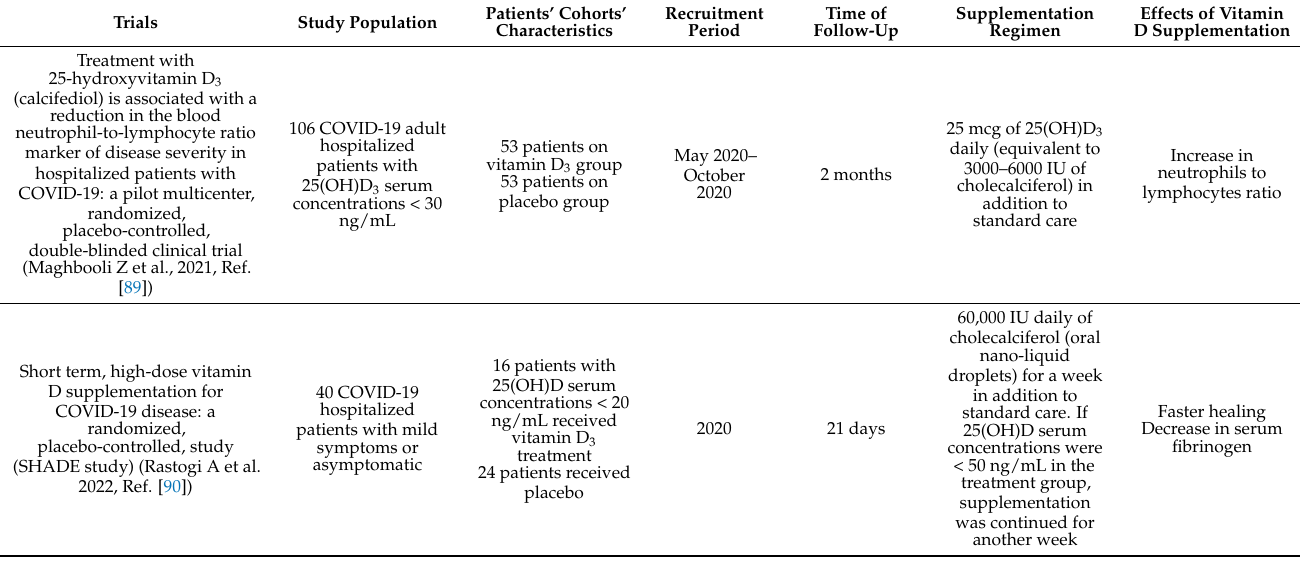
Table 1. Randomized double-blind, placebo controlled clinical trials regarding the biological and clinical effects of vitamin D supplementation in COVID-19 prevention and treatment. Recruitment Patients’ Cohorts’ Time of Period Characteristics